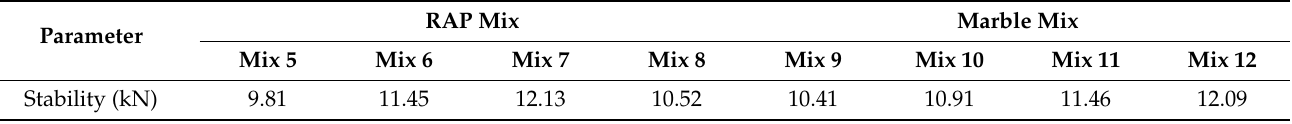
Table 6. Marshall Test Results for Sustainable Mixes.